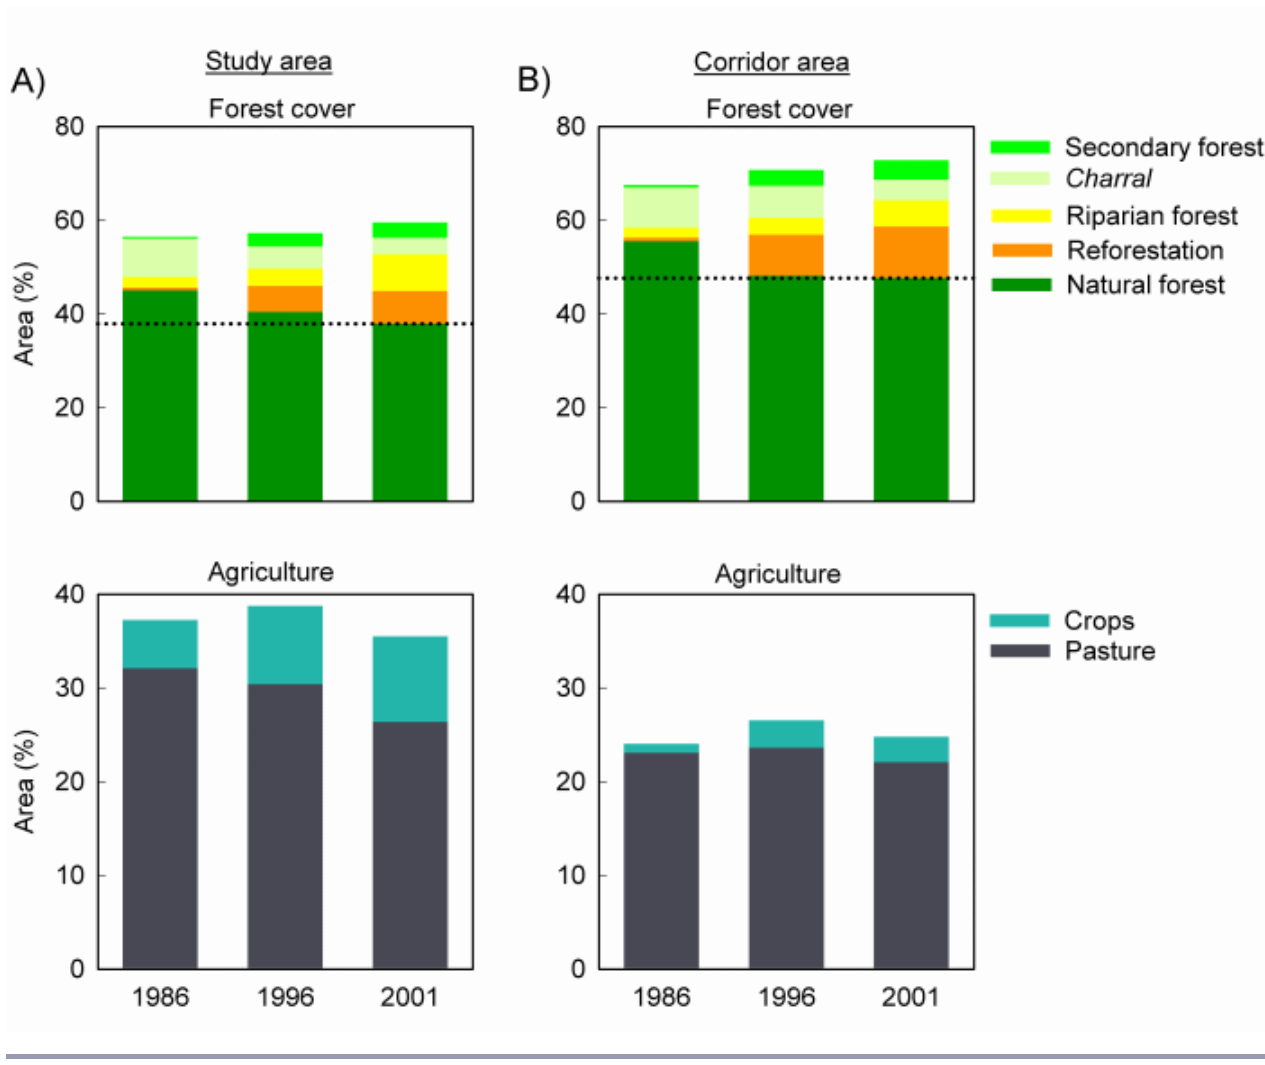
Fig. 3 . Area differences for each time interval for the five forest categories and two agricultural categories observed at (A) the extent of the study area (6349 km²) and (B) the San Juan-La Selva Biological Corridor (2425 km²). Dotted lines above the natural forest category show the top of the bar in year